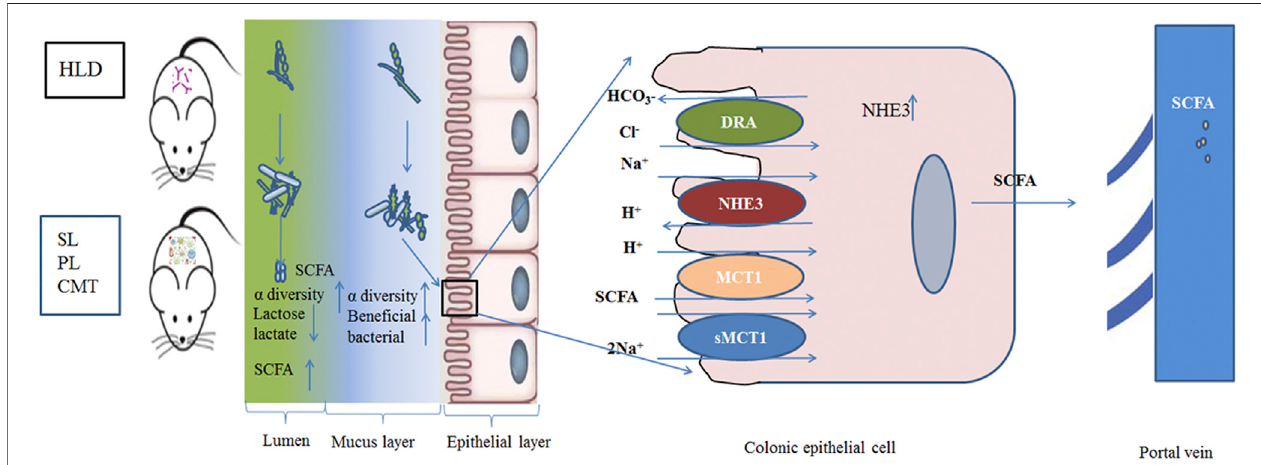
FIGURE 10 | Schematic of the experimental proposition that SL, PL and CMT treatment positively modulate gut microbiota with associated enhancement of lactose fermentation in HLD rats.